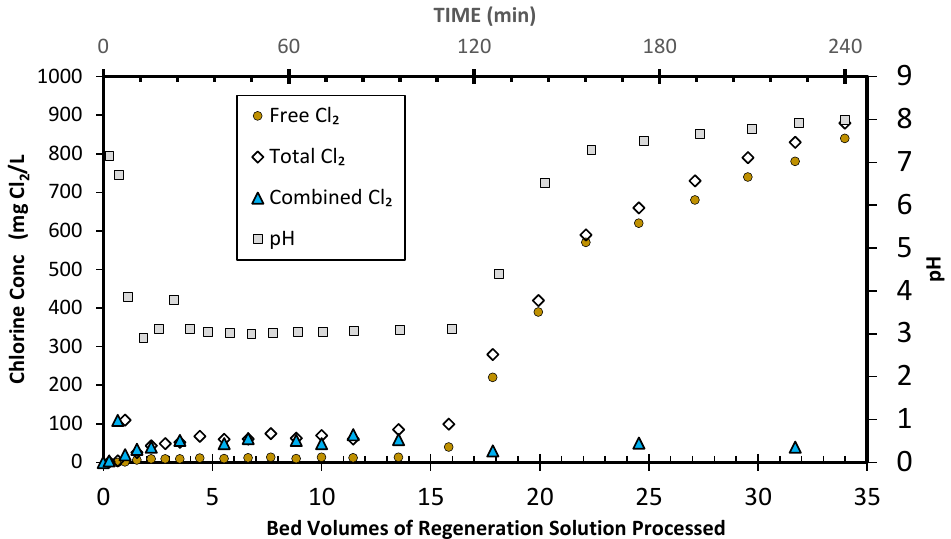
Figure 5. Effluent regenerant water quality during the 4 h-CS3 regeneration: pH, combined chlorine, total chlorine and free chlorine.